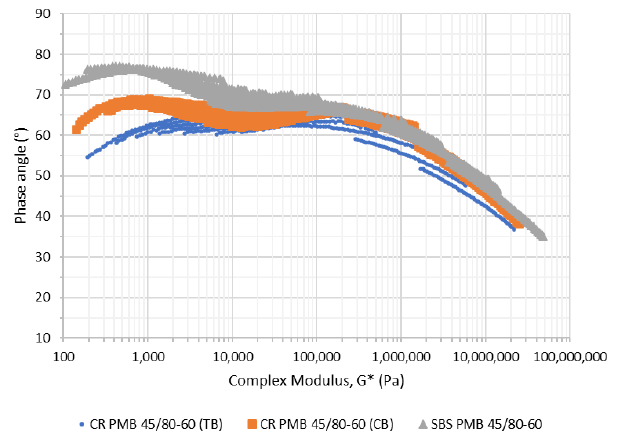
Figure 1. Rheological performance of the binders used in the manufacture of the mixtures.